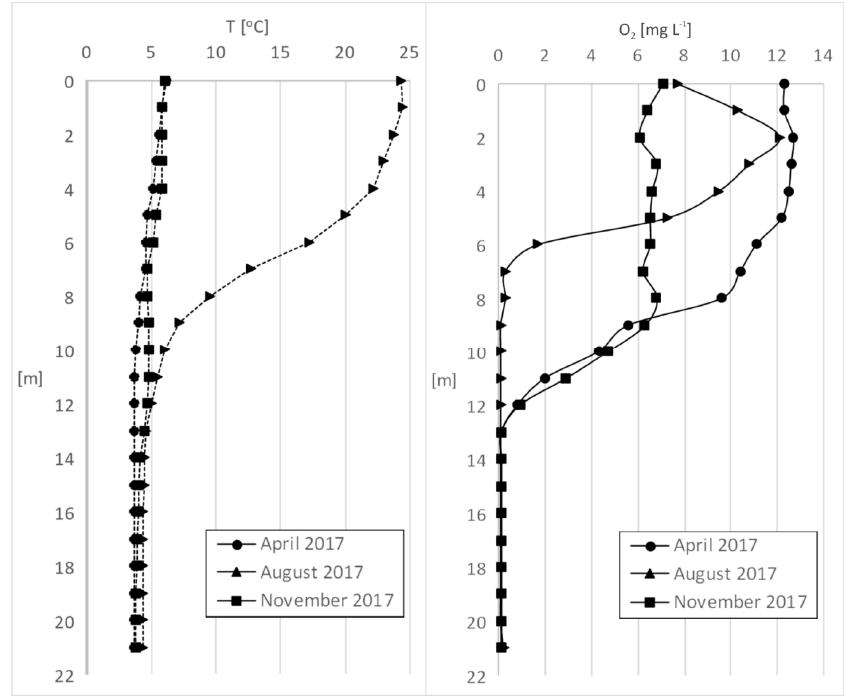
Figure 4. Vertical variability of temperature and oxygen concentration in Lubi ń skie Lake studied in 2017.